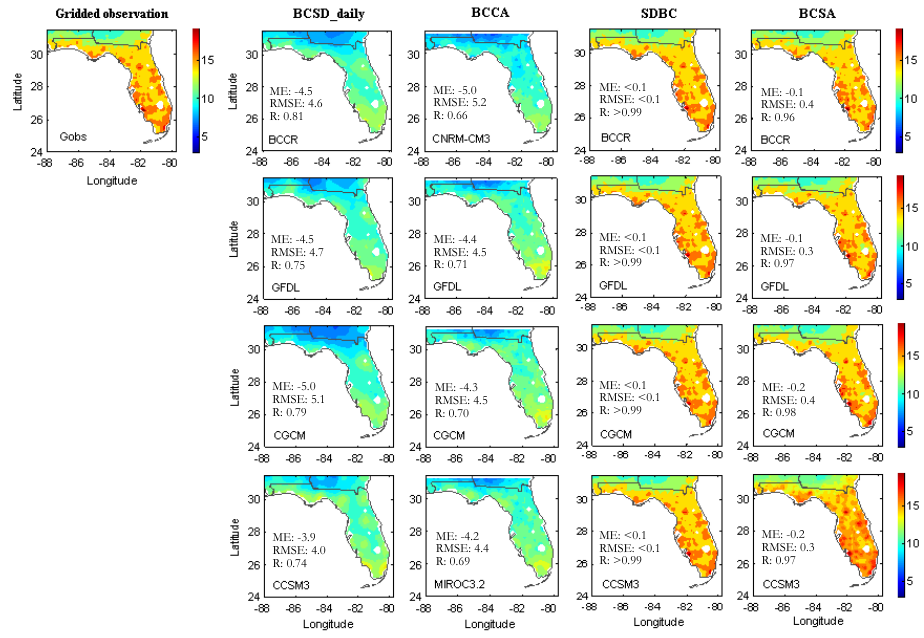
Fig. 8. Spatial distribution of the 90th percentile daily precipitation of Gobs, BCSD_daily, BCCA, SDBC, and BCSA GCMs for each grid cell for wet season (June through September), units in mm. ME, RMSE, and R are reported on each map for the bias-corrected predictions.